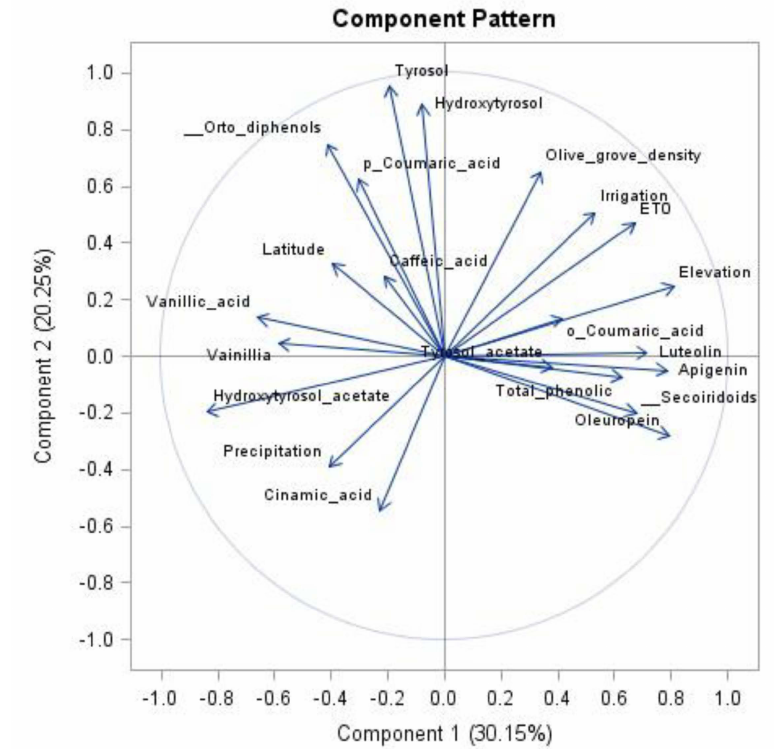
Figure 4. Principal component analysis (PCA) biplot (50.40% of explained variance) after Varimax rotation including main meteorological and orchard characteristics and the phenolic